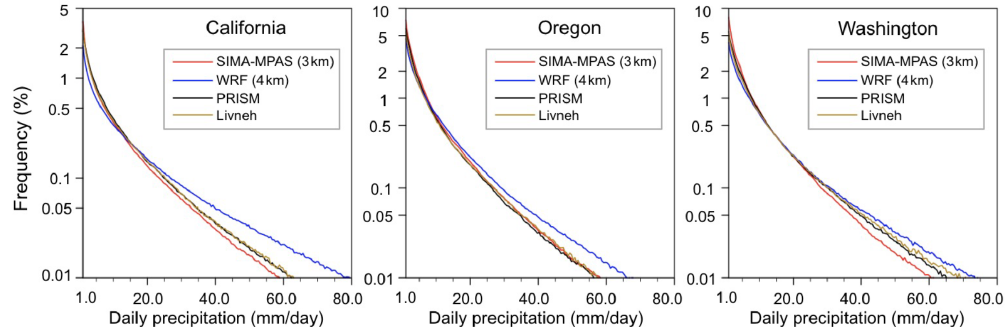
Figure 5. Probability distribution of daily precipitation intensity. All the daily datasets from the five wet seasons for all grid points in each state are used to construct the distribution statistics. The blue lines refer to WRF reference data; the black lines are for the PRISM observation; the dark golden line refers to the Livneh observation; and the SIMA-MPAS results are in red-colored lines. The SIMA-MPAS model data are regridded to the same resolution as the PRISM grid spacings (i.e., 4km). The x axis starts from 1mmd − 1 , and the y axis is transformed with a logarithmic scaling for better visualization of the upper tail